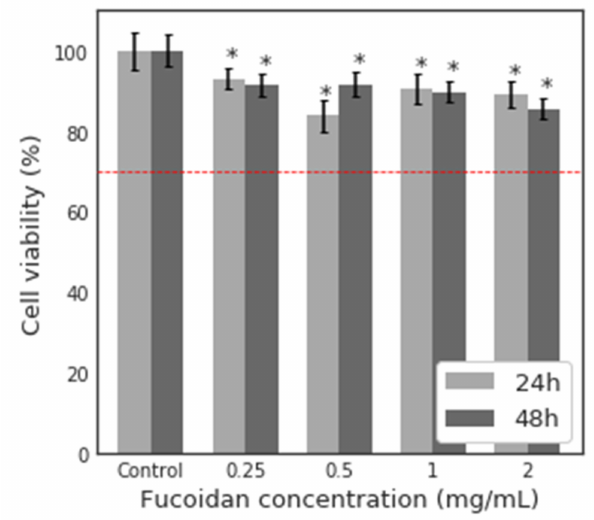
Figure 7. Relative viability (%) of MNT-1 cells, after 24 and 48 h exposure to different concentrations of fucoidan (0.25, 0.5, 1 and 2 mg mL − 1 ). Results were expressed as mean ± SD from three independent experiments. Statistical differences between the samples and control are represented by * when p < 0.05. The red dotted line at 70% is the toxicity limit, according to ISO 10993-5:2009(E). The cytotoxic effects were evaluated according to the standard ISO 10993-5:2009(E), in which a material is considered cytotoxic if cell viability is reduced by more than 30% [95]. It can be seen through Figure 5 that fucoidan is biocompatible for all concentrations and both exposure times with viability higher than 70%, even for the higher concentration (2 mg mL − 1